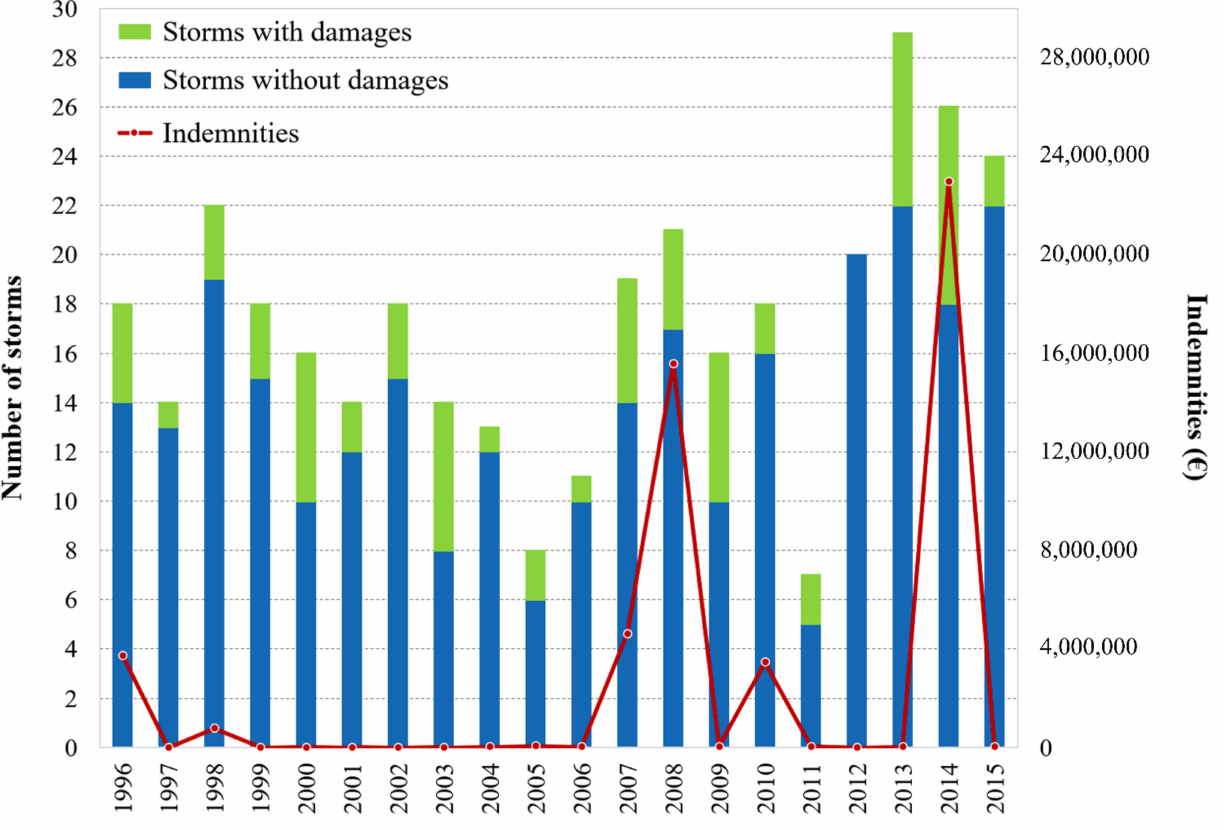
Figure 5. Interannual distribution of storms: number of wave storms and damaging storms, and amount of